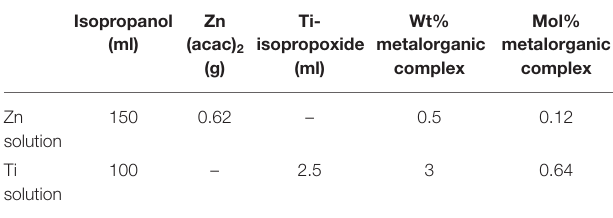
TABLE 1 | Composition of precursor solutions.